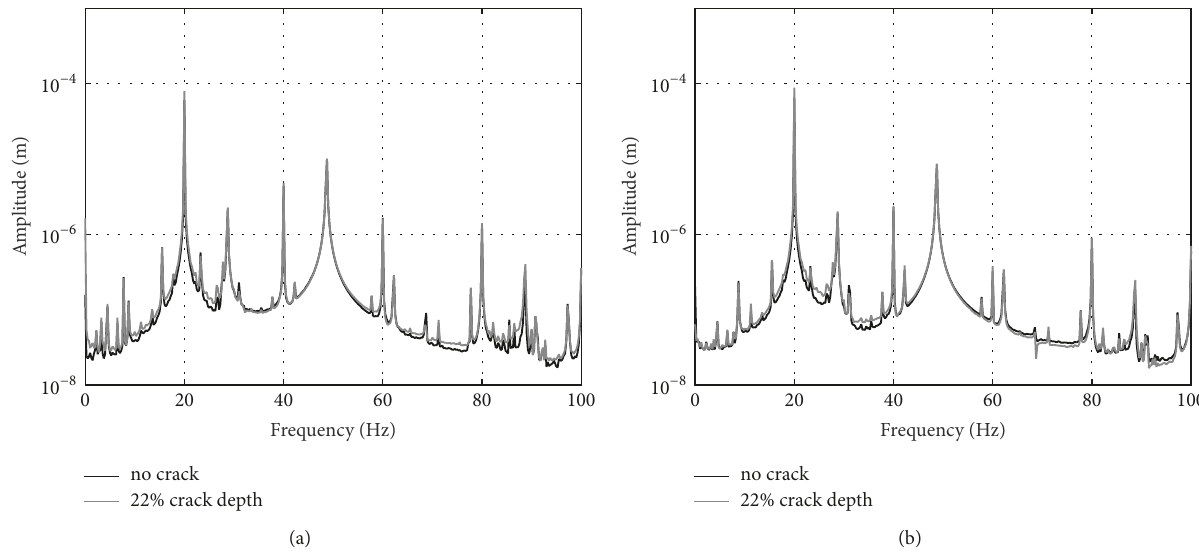
Figure 15: FFTs of the rotor vibration responses for the healthy and cracked shaft. Experimental responses as excited by the diagnostic frequency of 48.7 Hz at node #4: (a) horizontal response at node #8; (b) horizontal response at node #28.